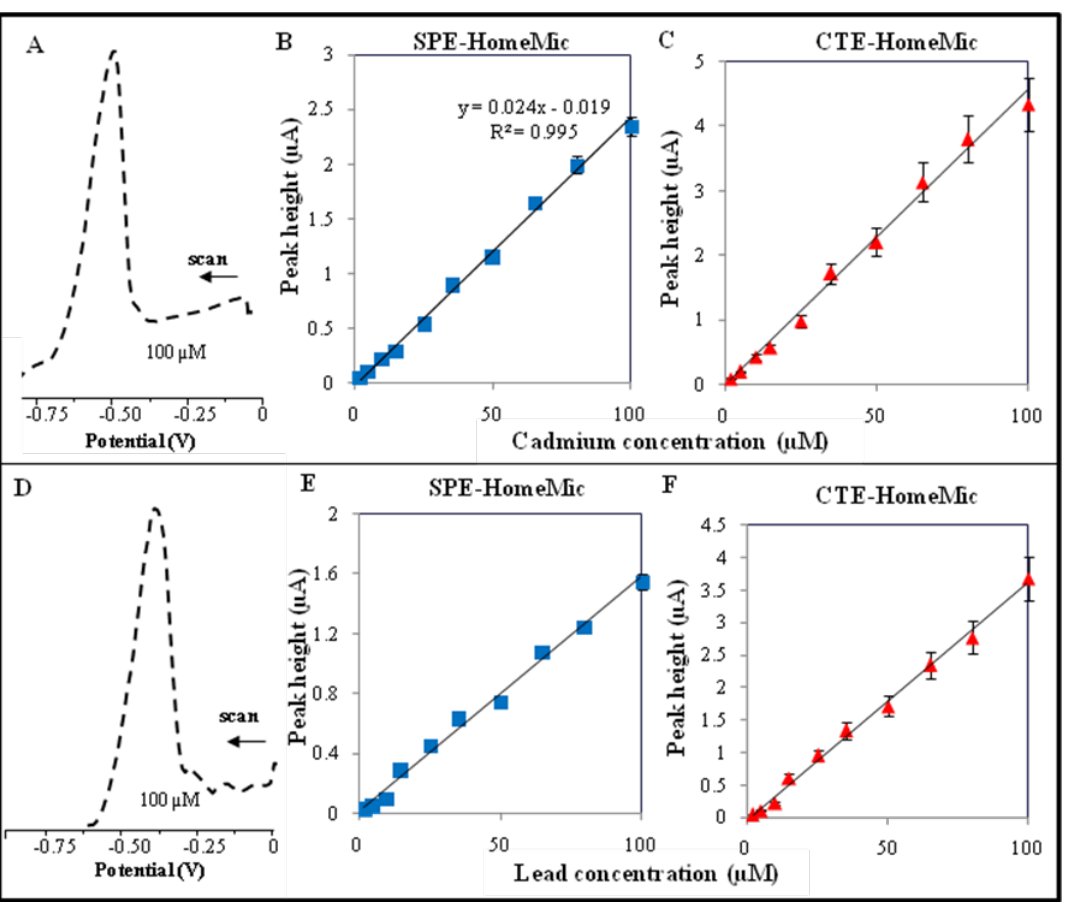
Figure 6. Cadmium(II) ions. (A) DP voltammogram of cadmium(II) ions detected at SPE. Calibration curves measured with (B) SPE and/or (C) CTE. Lead(II) ions. (A) DP voltammogram of lead(II) ions detected at SPE. Calibration curves measured with (B) SPE and/or (C) CTE. Poteniostat: homemade. Experimental parameters were as follows: initial potential 0 V, end potential –0.8 V, potential step 5